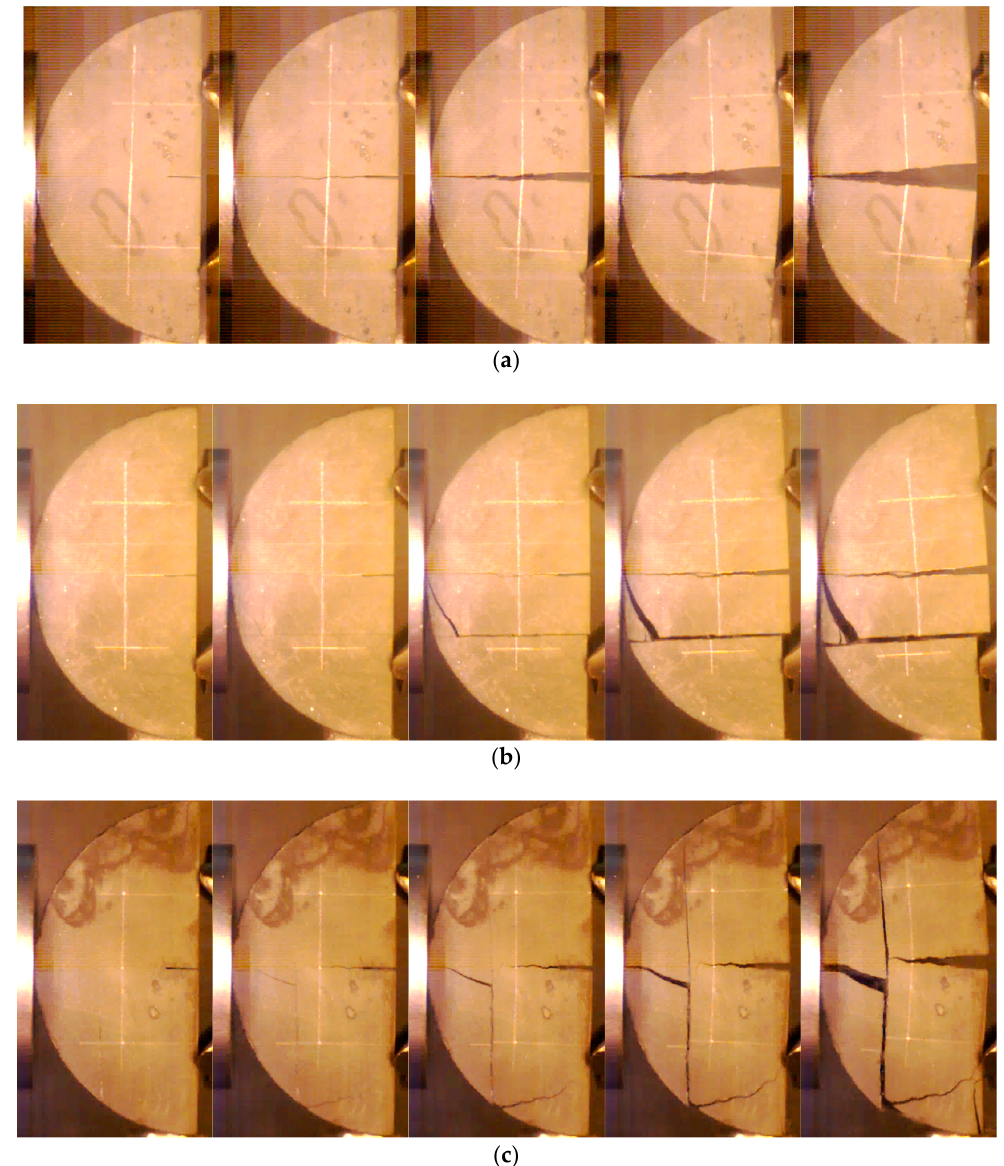
Figure 6. Fracture processes of shale samples for different loading configurations. ( a ) Crack-divider; ( b ) Crack-splitter; ( c ) Crack-arrester.